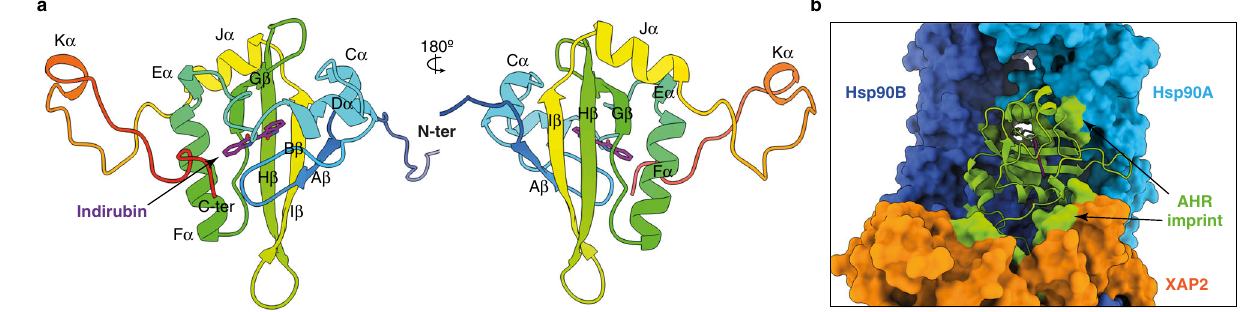
Fig. 2 | Structure of the AHR PAS-B domain. a Two opposing views of the PAS-B domain in cartoon representation coloured in rainbow from N- to C-terminus. The elements of the secondary structure are labelled. The indirubin molecule is shown